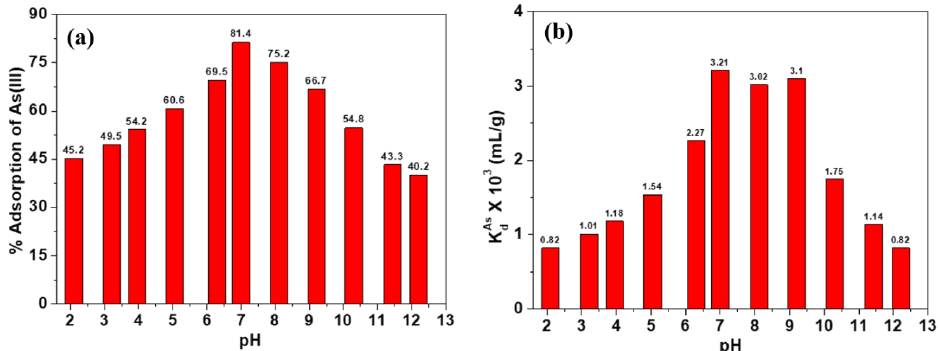
Figure 4. Effect of pH for the adsorption of As(III) using PP@TiO 2 from water: ( a ) Adsorption % of As(III) by PP@TiO 2 ; ( b ) Distribution coefficient (K D ) of As(III) adsorption at different pH. (Conditions: m = 25 mg, V = 25 mL, V:m = 1000 mL/g, T = 25 °C, contact time = 24 h).